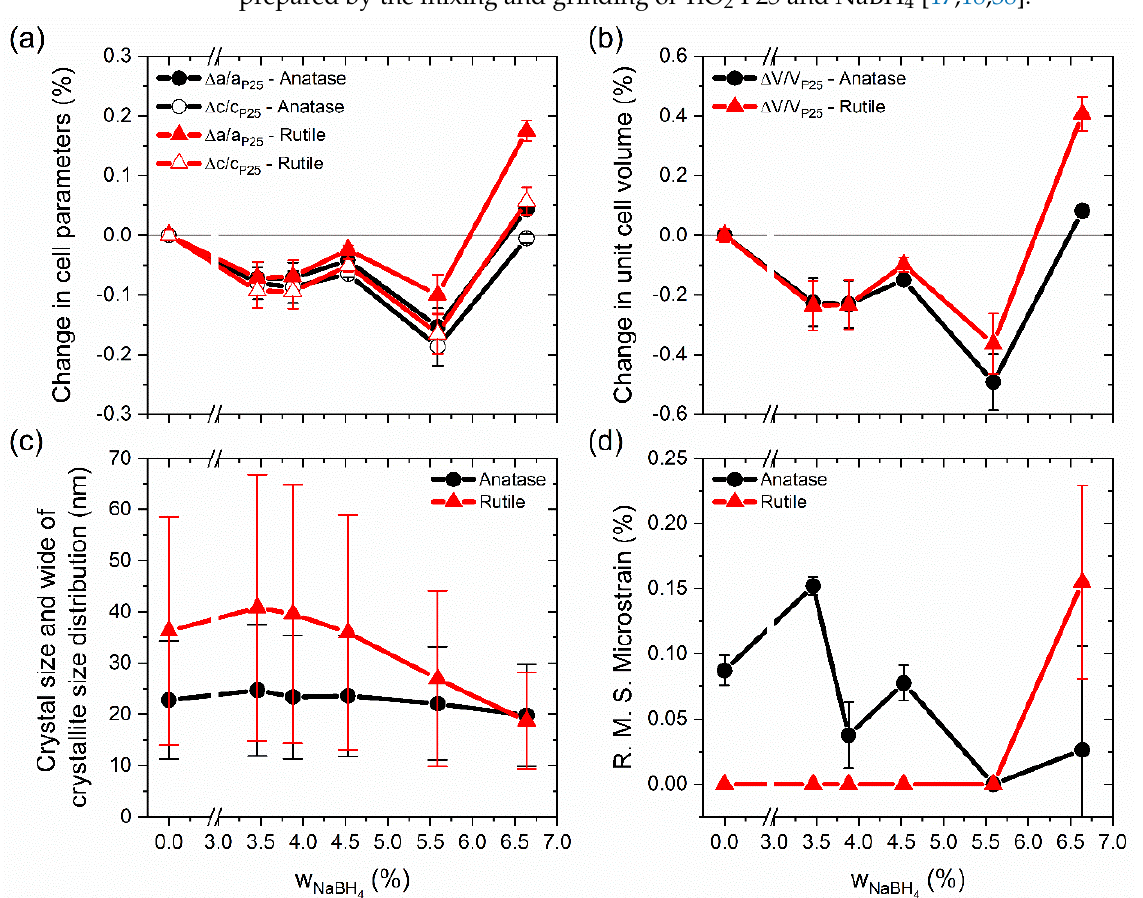
Figure 2. Changes in ( a ) cell parameters and ( b ) unit cell volume with respect to TiO 2 P25. In ( c ), crystal size corresponds to a volume-weighted mean sphere diameter and distribution width (bars); ( d ) shows microstrain variation.